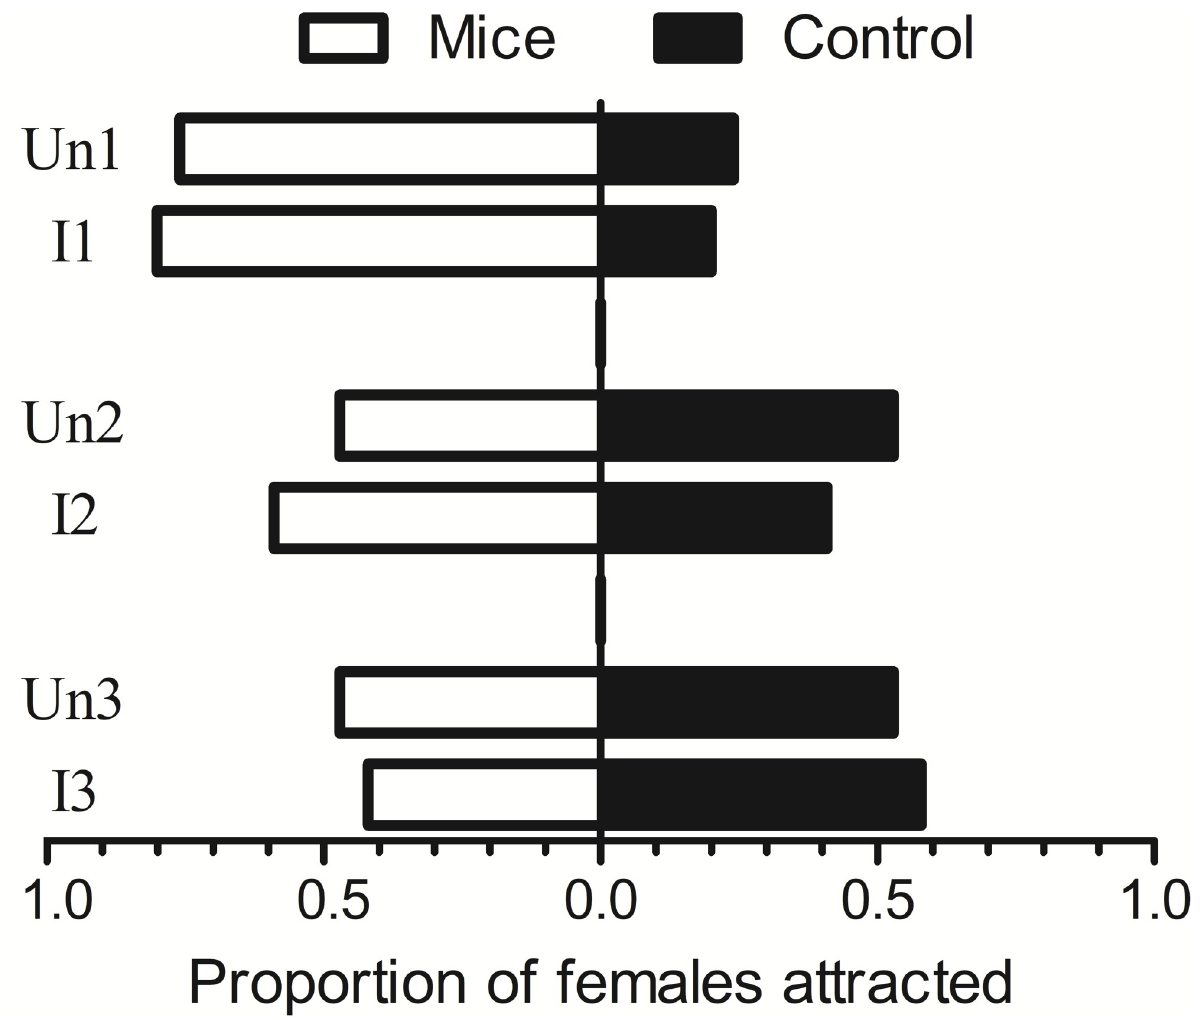
Fig 4. Proportions of females attracted to uninfected (Un1, Un2, and Un3) and infected (I1, I2, and I3) mice in Y-tube olfactometer trials; n = 30/